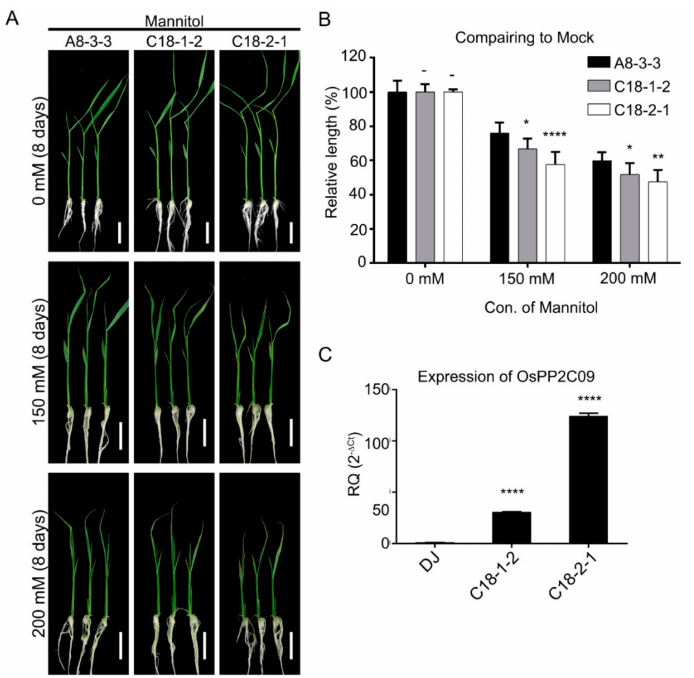
Figure 4. C18 plants, overexpressing OsPP2C09 , are hypersensitive to osmotic stress. ( A ), A8 and C18 plants transferred after the two-leaf stage to half-strength MS medium containing the indicated mannitol concentrations for 8 d. ( B ), Shoot lengths were measured, with six or more seedlings per replicate. Relative shoot length for A8 and C18 seedlings, normalized to mock control (0 mM mannitol). The values are means ± SD ( n = 3). The experiment was repeated three times with similar results. Two-way ANOVA was performed comparing with A8 plants (****: p < 0.0001, **: p < 0.01, *: p < 0.05, -: not significant). ( C ), Relative transcript levels of OsPP2C09 in C18 seedlings. All values were determined by RT-qPCR and normalized to UBIQUTIN5 before normalization to relative transcript levels in Dong-Jin (DJ), shown as mean of relative quantity and SD. One-way ANOVA was performed (****: p <